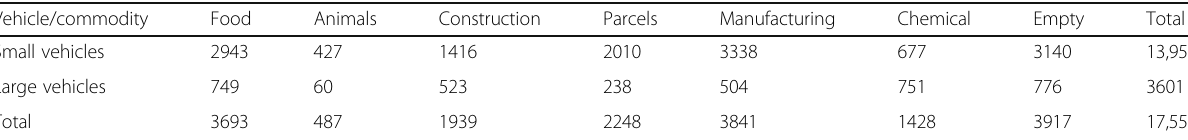
Table 2 Commodities transported by vehicle type